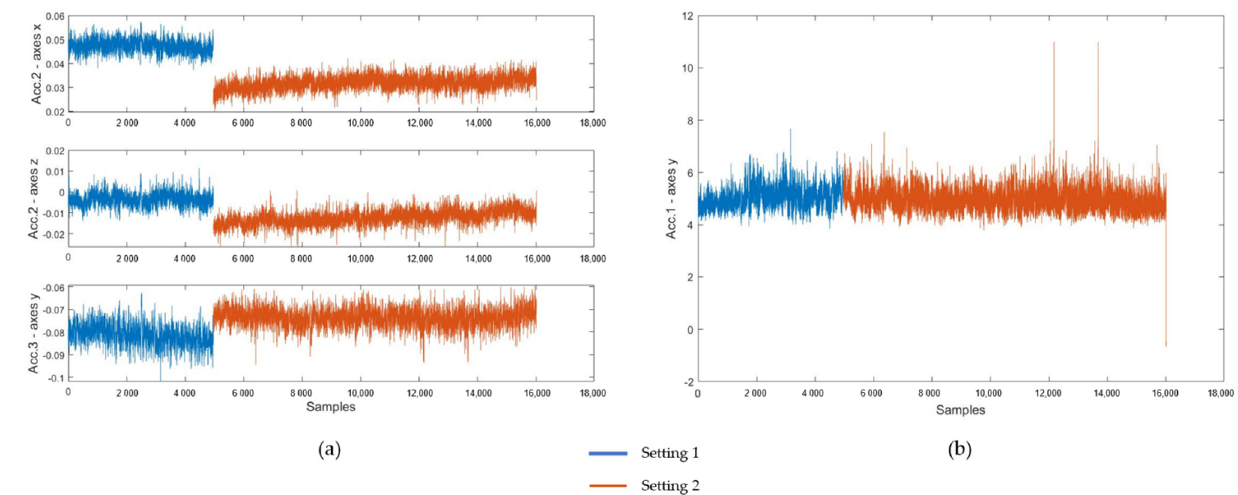
Figure 8. ( a ) Features selected for condition recognition; ( b ) Feature selected for fault detection.